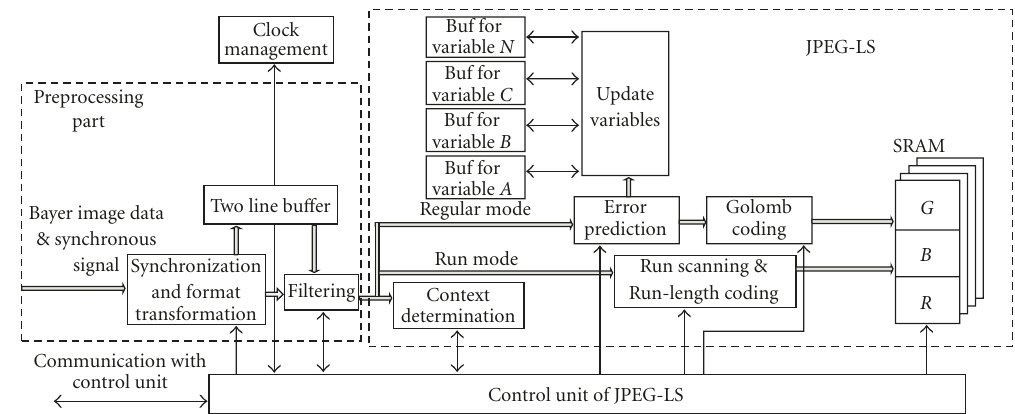
Figure 12: The VLSI architecture of the proposed image compression algorithm.